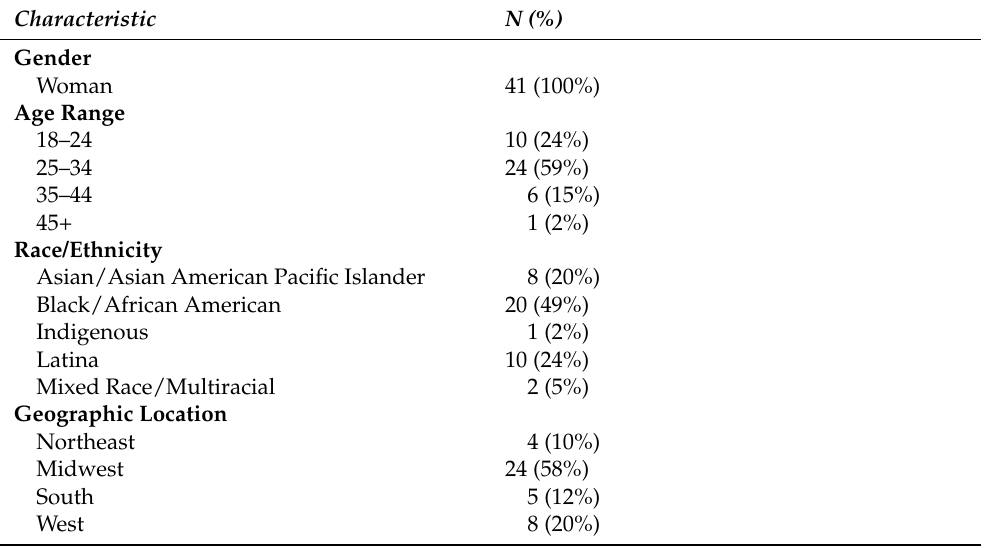
Table 1. Demographic Characteristics of the Participants ( N =